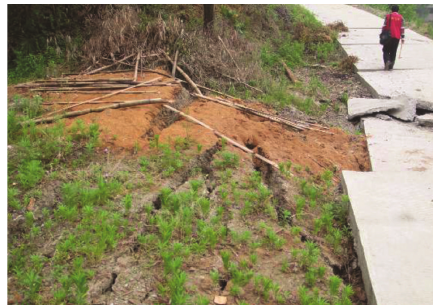
Figure 5: Ground fissures near a surface rupture fault.